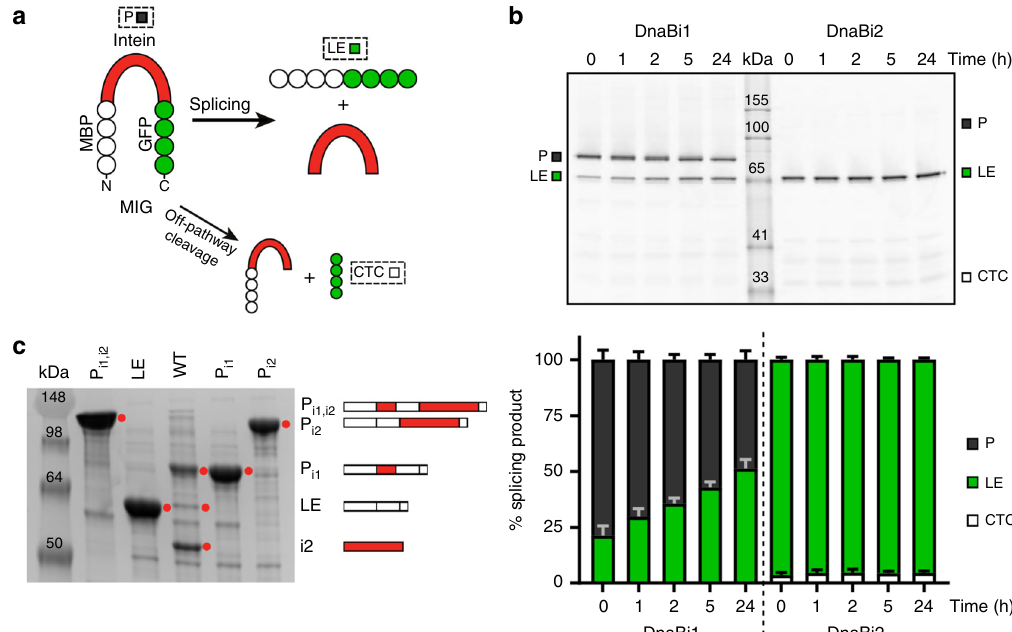
Fig. 2 Different splicing pro fi les of M. smegmatis DnaB inteins. a Schematic of MIG. The reporter construct maltose-binding protein (MBP)-intein-GFP (MIG) allows monitoring of splicing by in-gel fl uorescence of GFP-containing products 3 . The precursor molecule (P) can splice, yielding ligated exteins (LE) and free intein (I), or can undergo off-pathway cleavage reactions, such as C-terminal cleavage (CTC). b The two Msm inteins have distinct splicing. The gel of a splicing time course shows that MIG DnaBi1 splices slowly while MIG DnaBi2 splices almost instantaneously. Quantitation of MIG time course is shown below (stack plots), where the ratios of splice products were plotted. Data are representative of three biological replicates and values are expressed as mean ± s.d. c Splicing of Msm DnaB inteins with native exteins corresponds to splicing in MIG. Full-length DnaB protein constructs were made to understand how the inteins splice with native exteins. The wild-type (WT) lane represents lysate of overexpressed DnaB protein with splicing-competent inteins. The adjacent lanes are lysates containing splicing-inactive controls representing possible splicing outcomes and are schematically indicated. These splicing products include full precursor with both inteins present (P i1,i2 ), alternative precursor 1 (P i1 ), with only DnaBi1 present, alternative precursor 2 (P i2 ), with only DnaBi2 present, and ligated exteins (LE), with no inteins present. In WT there is accumulation of P i1 , which indicates rapid splicing of DnaBi2. Consistent with this observation, abundant DnaBi2 is visible in the WT lane. Bands of interest are indicated by red circles. Data are representative of